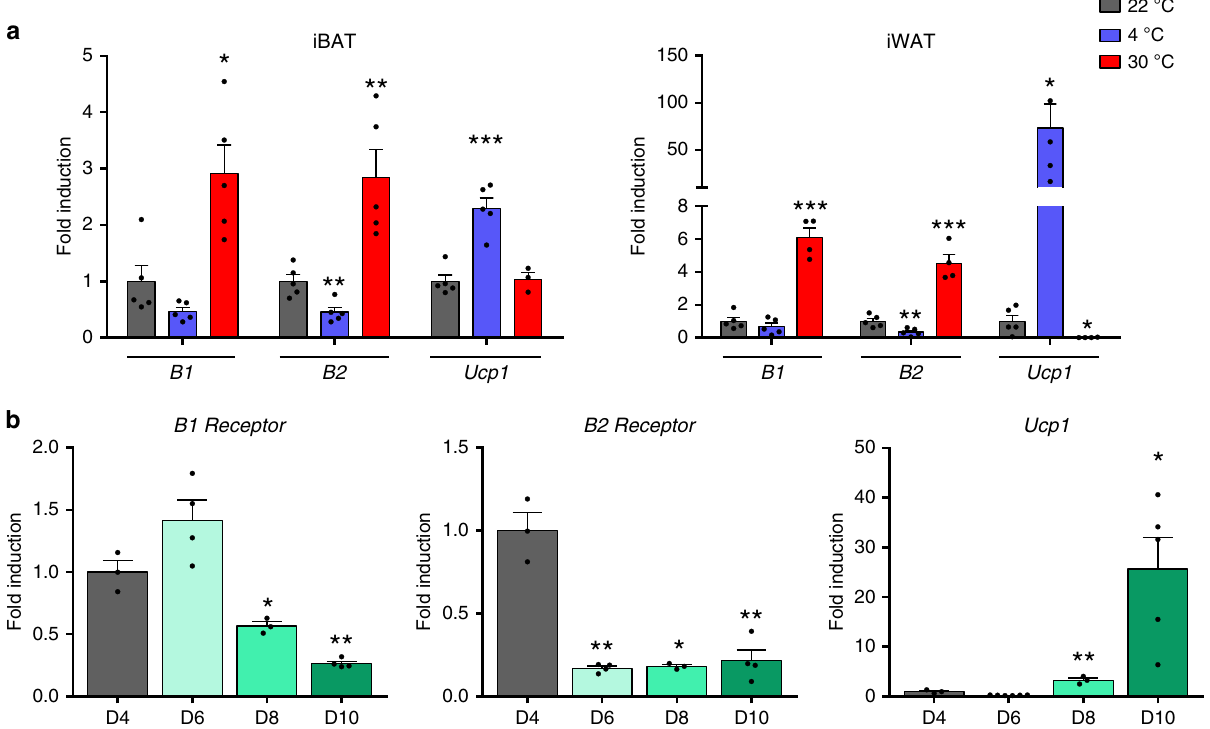
Fig. 4 B1 and B2 receptor expression. a B1 and B2 receptor mRNA expression in iBAT and iWAT of mice exposed to cold or thermoneutrality for 1 week ( n = 5 animals except for iBAT Ucp1 30 °C where n = 3 and iWAT 30 °C all genes where n = 4). Ucp1 is shown as a control for the ef fi ciency of thermogenic challenges. b mRNA expression of B1 and B2 receptors during differentiation (D4 – 8) and in fully differentiated brown adipocytes (D10) ( n = 3 independent cell culture experiments for D4 and D8 and n = 4 for D6 and D10 for B1 and B2 genes; n = 3 for D4 and D8 and n = 6 for D6 and n = 5 for D10 for Ucp1 gene). Ucp1 is shown as a positive control for differentiation. Data are presented as means ± s.e.m. (bars). * P < 0.05, ** P < 0.01, and *** P < 0.001 versus corresponding controls; one way ANOVA with Tukey ’ s post hoc test. Source data are provided as a Source data fi